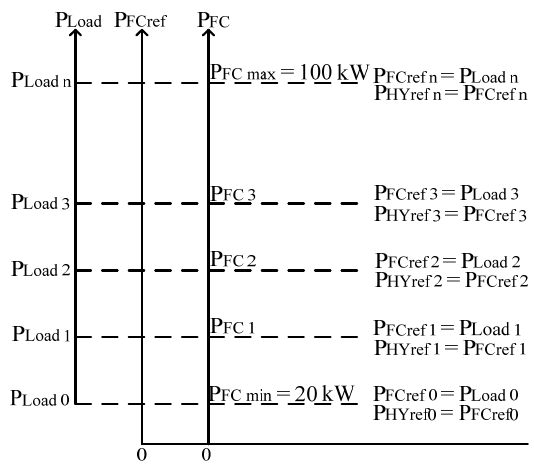
Figure 3. Operating strategy of fuel cell when P PV 0 = 0.